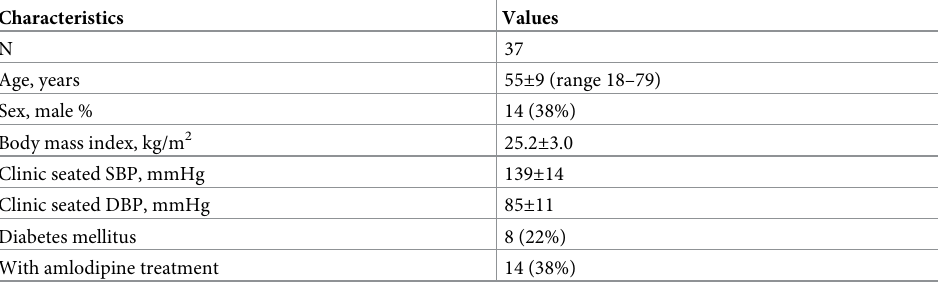
Table 1. Demographic and clinic characteristics of study subjects.